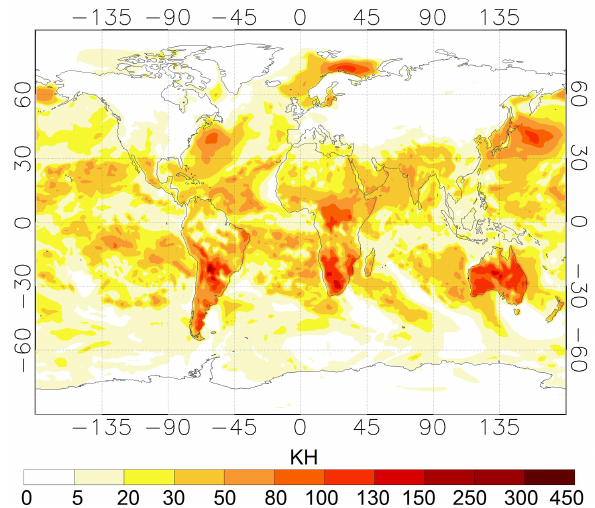
Figure 1. Daily mean diffusion coefficient (KH) at 1.25 ◦ × 1.0 ◦ for 30 July 2002 at pressure level about ∼ 950hpa in MERRA reanal- ysis. The diffusion coefficient is determined using a K -diffusion scheme in MERRA